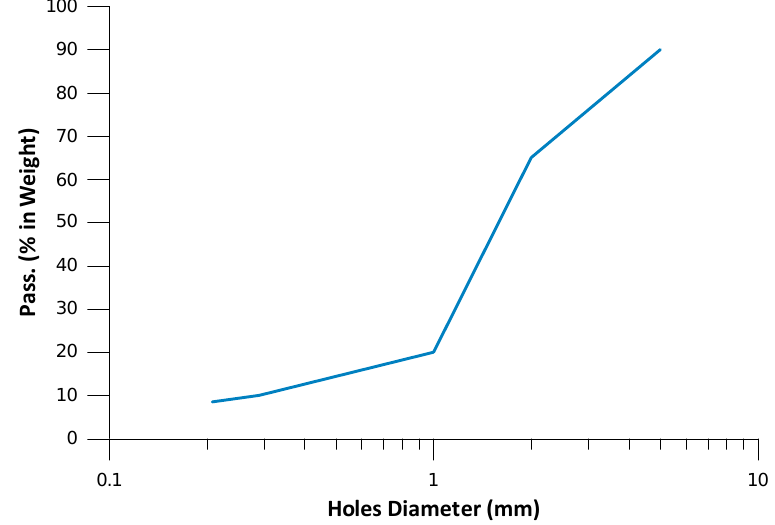
Figure 2. Granulometric curve of blast-furnace slag.